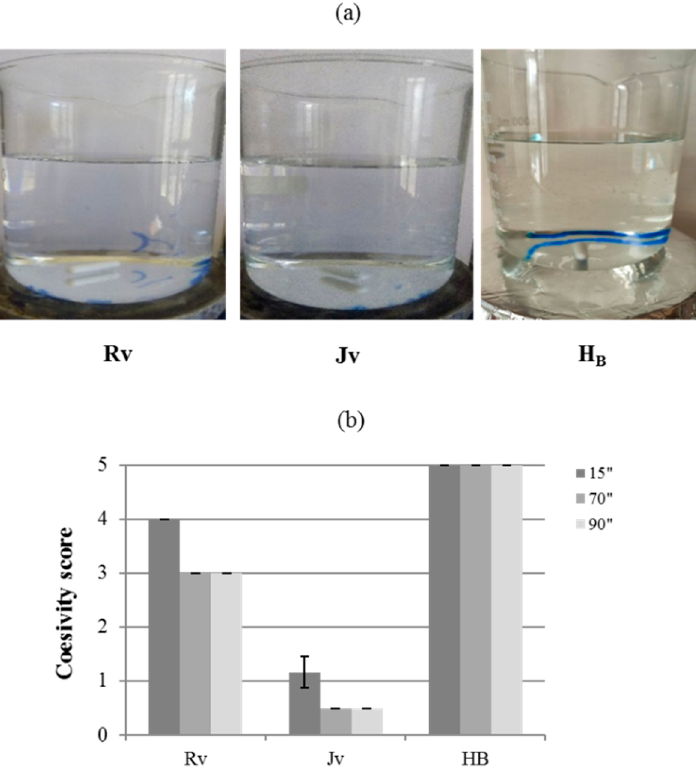
Figure 5. Gel cohesivity. ( a ) Images of the gels at 15 s after starting the test. ( b ) Cohesivity score assigned to the gels at diverse time intervals according to the Gavard–Sundaram Cohesivity Scale [20].